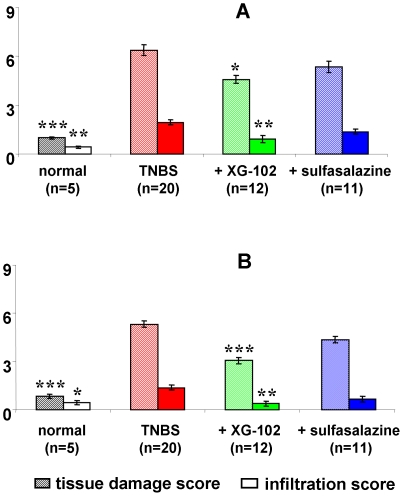
Hematoxylin and eosin (H&E) scores.Hematoxylin and eosin (H&E) scores from distal (A) and medial (B) colon. For the tissue damage score (hatched bars), the scores of ulcer, crypts and submucosa were summed-up for each individual animal, and the mean±SEM was calculated for each group. The mean±SEM of the infiltration score (grey bar) is separately shown. ***, ** = p<0.001 and p<0.01 for all groups compared with TNBS group.